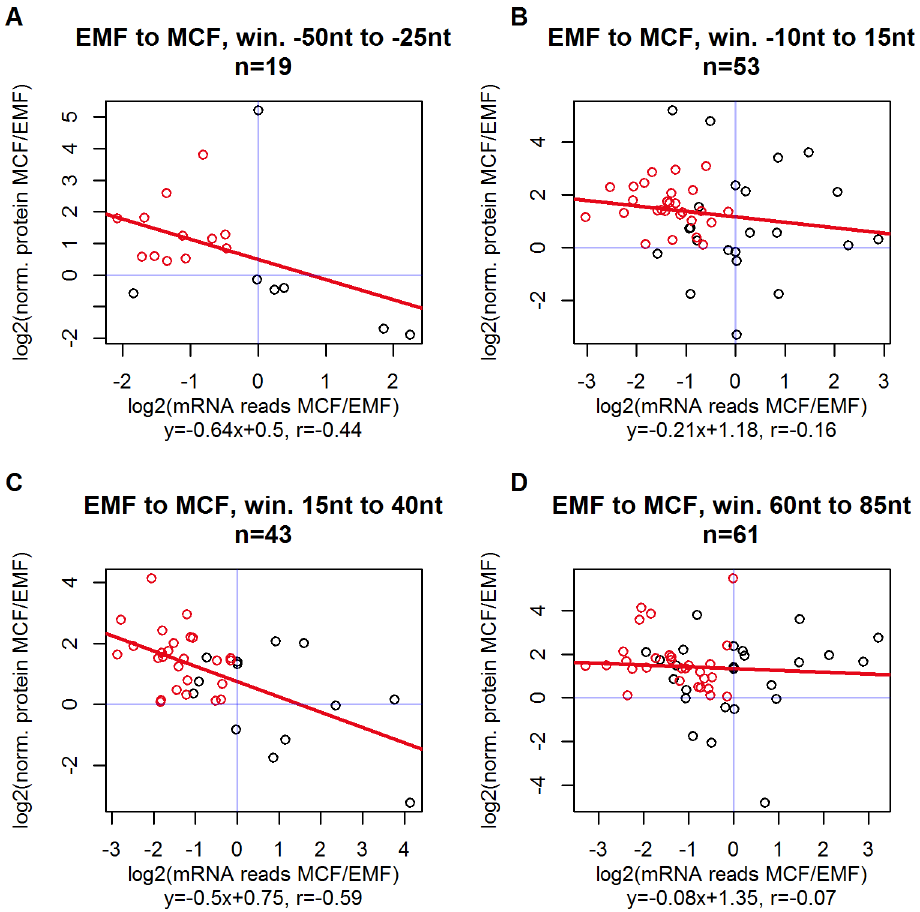
Fig 10. uORFs of the proteomic data subset undergo characteristic changes around EMF stage. Red scatters indicate uORFs that have been previously overweighted from PCF to EMF (see Fig 9, bottom right quadrant) and release their translation repression from EMF to MCF stage (top left quadrant). Underrepresentation of overlapping and proximal uORFs corresponds to the largest incline of protein expression (see gradually decreasing slope from panels A to D ). For general graph description see Fig